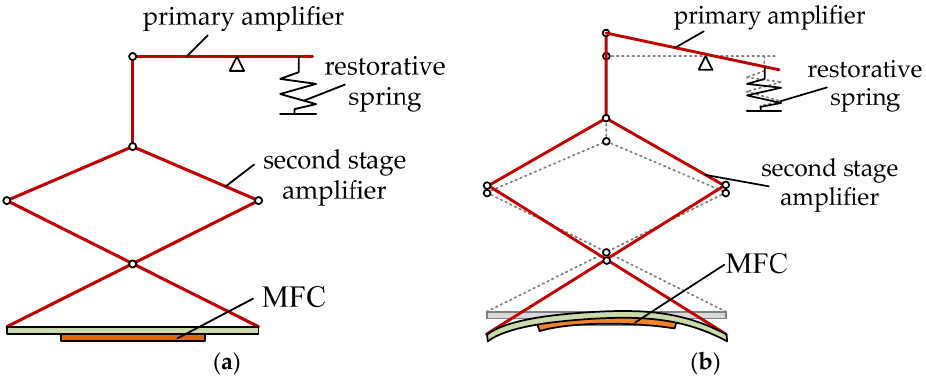
Figure 2. Operating principle of the vibration piezoelectric generator. ( a ) The MFC is not deformed; ( b ) the MFC is deformed.